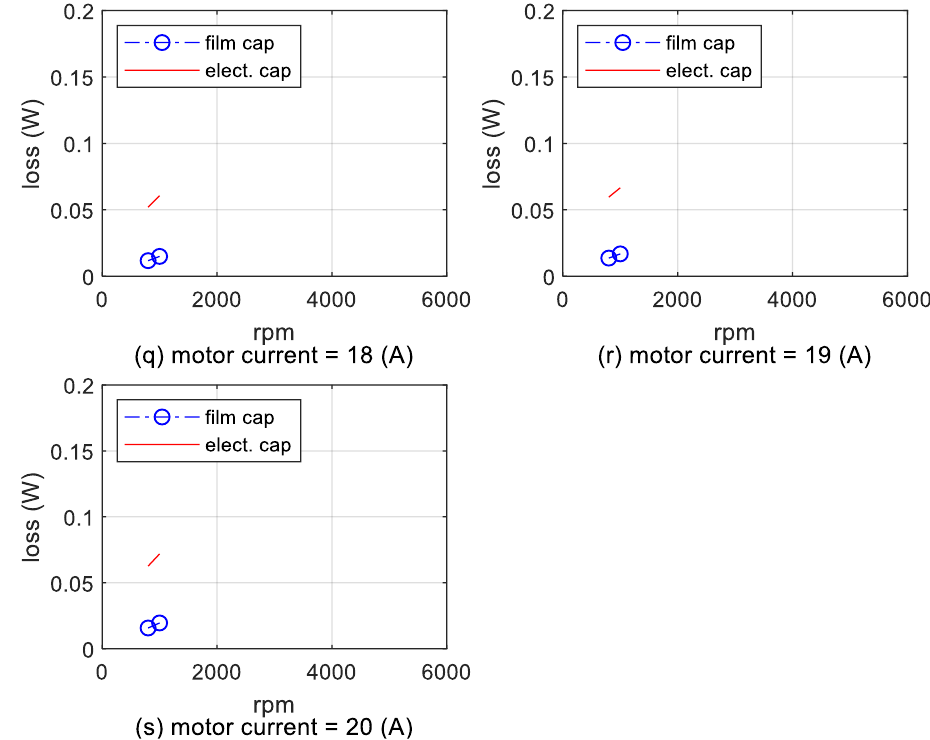
Figure 23. Comparative results of losses in the two capacitors used in the electric compressor systems. Table 6. Comparative results of losses in the two capacitors at a speed range of 800–2000 rpm.